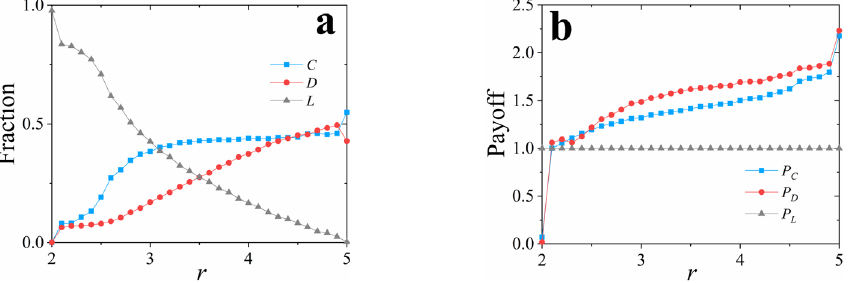
Figure 3. Cooperation level of the population ( a ) and the corresponding average payoff for strategies ( b ) as a function of r . The parameters are ω = 0.02, α = 1, γ + = γ − = 0.5, λ = 2, M = 100. When the difference in weight between C and D is considered, the fractions of strate- gies vary nonlinearly with ω C and ω D (Figure 4). In general, when r = 3.5, a low ω C value and high ω D value can significantly promote the level of cooperation (Figure 4a). If